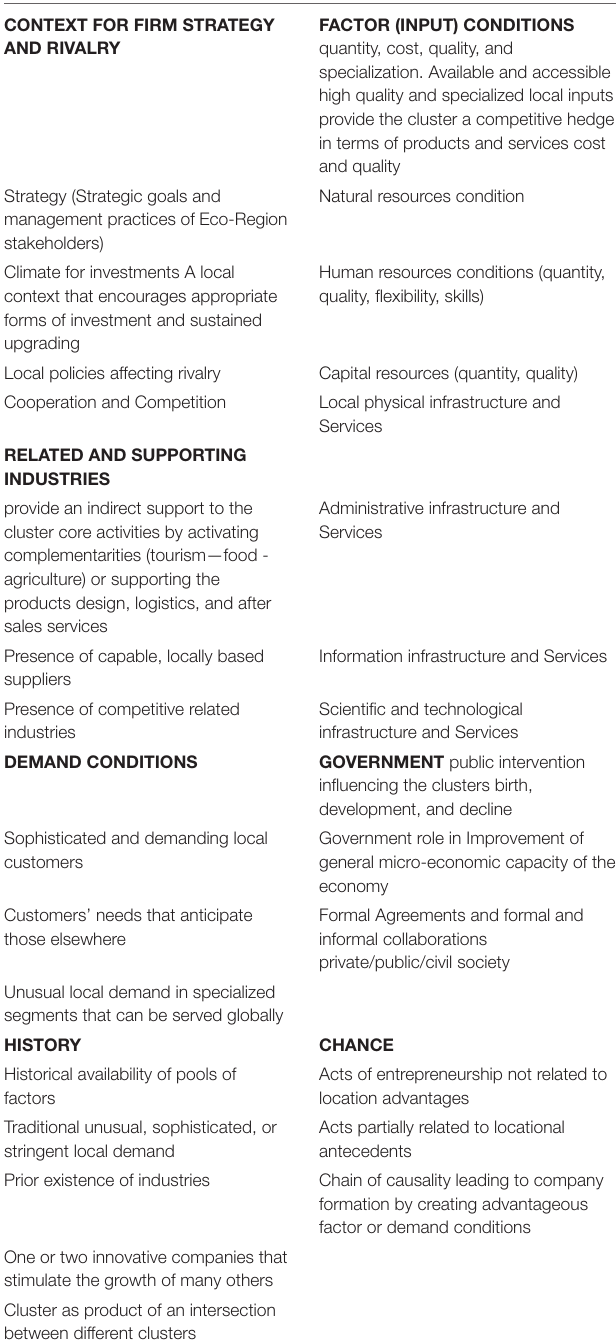
FACTOR (INPUT) CONDITIONS quantity, cost, quality,